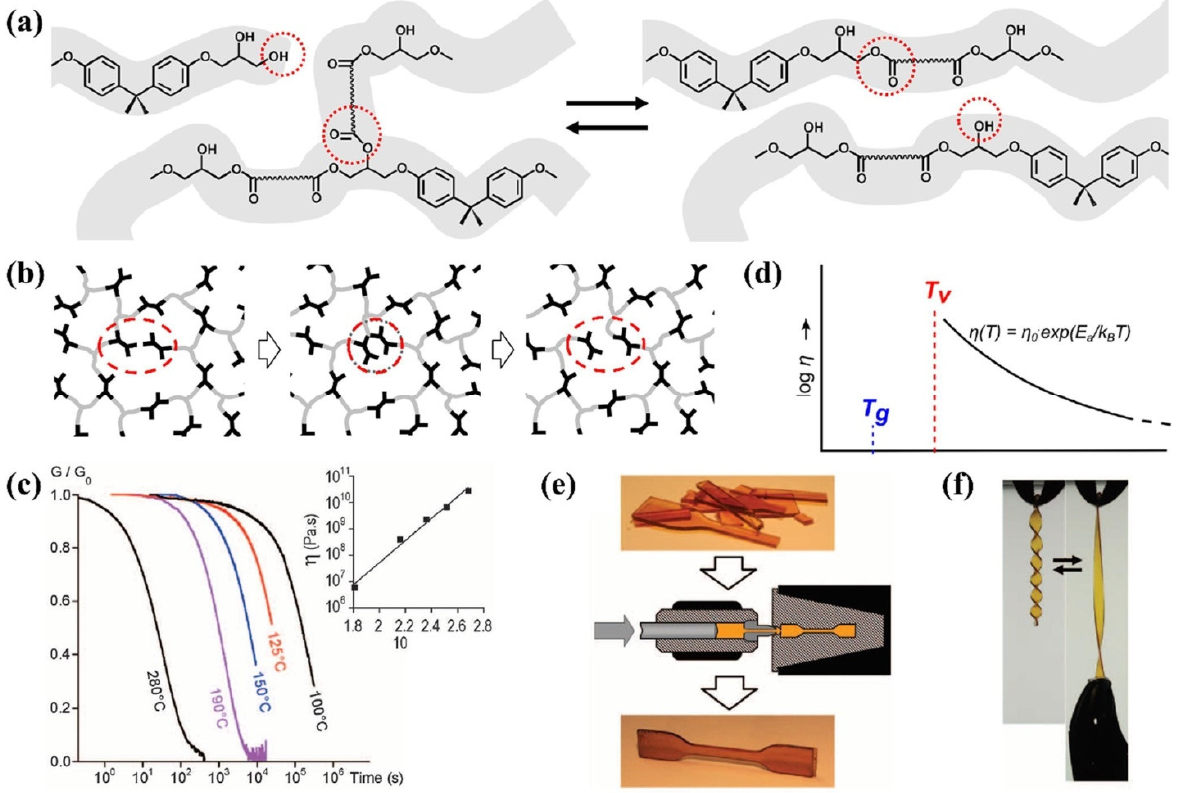
Figure 4. ( a ) An illustration of transesterification in hydroxyl ether networks. ( b ) Topological rearrangements through exchange reactions that preserve the integrity of the network. ( c ) Normalized stress relaxation at various temperatures. The inset shows the change in viscosity with temperature at zero shear. ( d ) The viscosity of the vitrimer follows the Arrhenius law with increasing temperature. ( e ) Remachining broken parts on an injection molding machine to restore their original appearance and properties. ( f ) Shaping the sample into a fusilli shape. Reprinted with permission from [79]. Copyright (2022) the American Association for the Advancement of Science (AAAS) and from [68]. Copyright (2019) American Chemical Society.